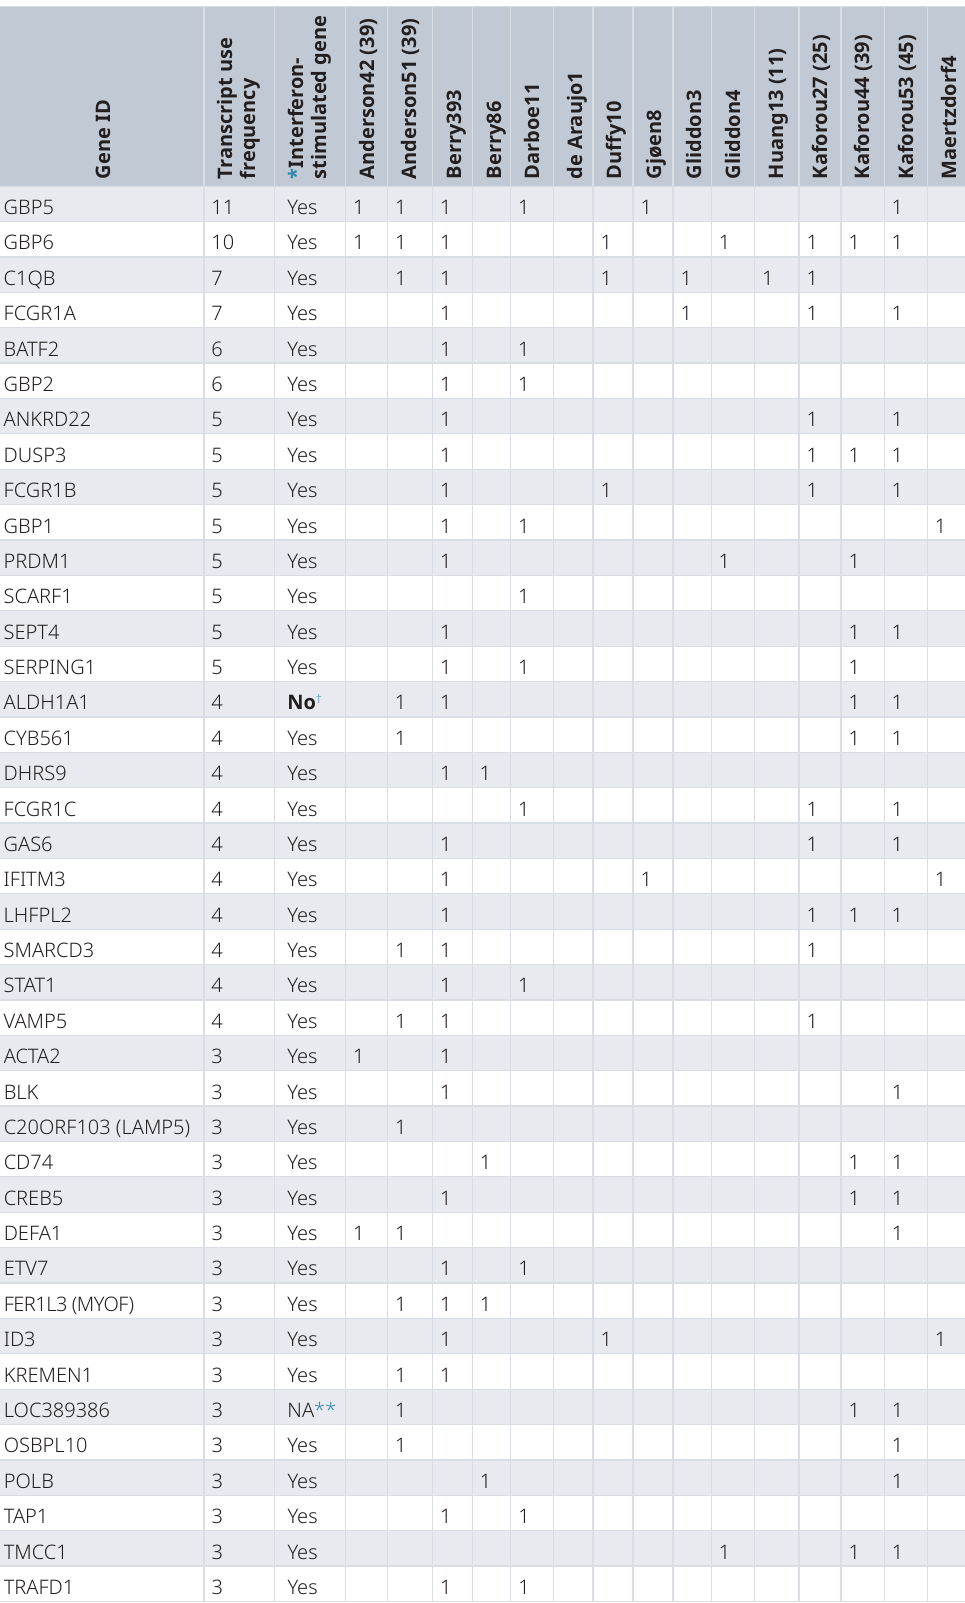
Table 4. Forty most frequent transcripts included in 3 or more transcriptomic signatures, sorted by transcript use frequency.